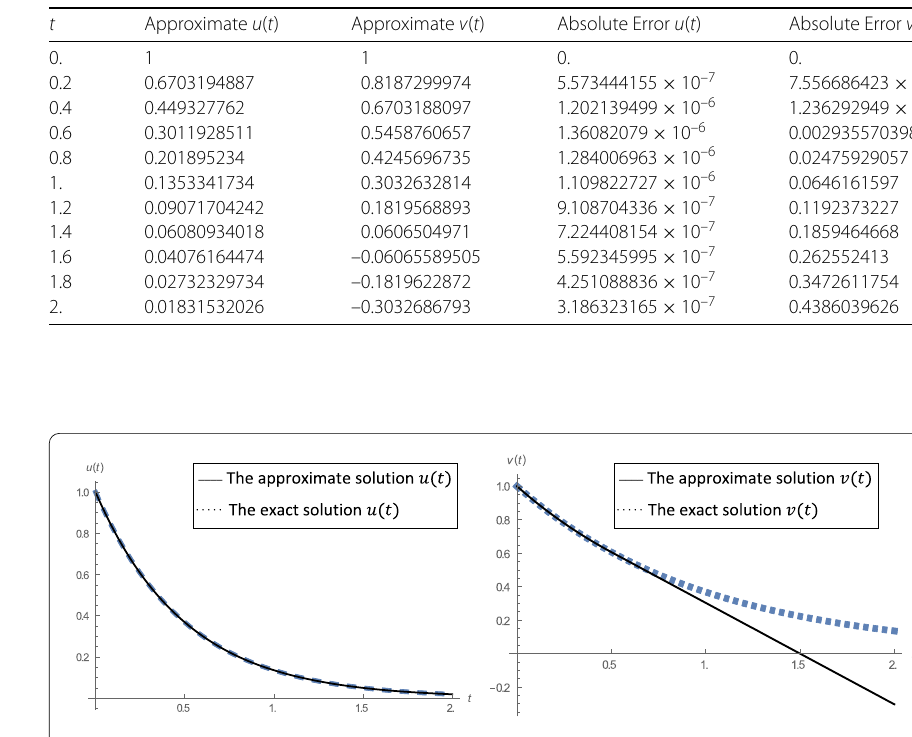
Table 4 Numerical results and approximated RKHS-solutions of Example 4.2